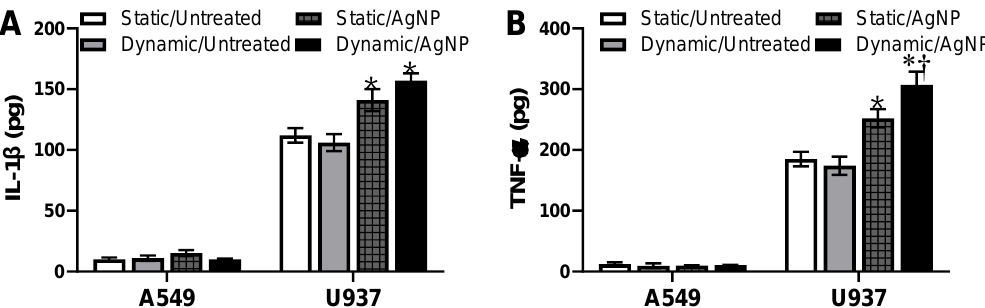
Figure 6. Secretion of pro-inflammatory cytokines following AgNP stimulation. The alveolar epithelial A549 and monocytic U937 cell lines were exposed to the denoted combinations of static/dynamic conditions and 5 µg/mL AgNPs. After 24 h the media were recovered and evaluated for levels of the pro-inflammatory cytokines of ( A ) IL-1β and ( B ) TNF-α. * and † indicate statistical significance compared to the untreated control and between static and dynamic conditions, respectively. n = 3, p < 0.05.